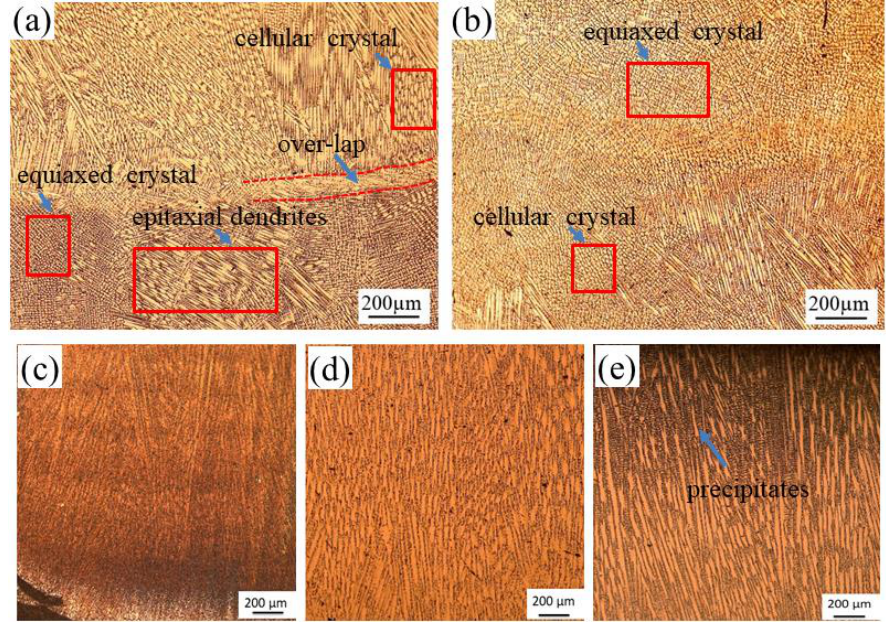
Figure 3. Optical microstructures of the HX1 and HX2 coatings: ( a ) the microstructure of the surface of the HX1 coating; ( b ) the microstructure of the surface of HX2 coating; ( c – e ) the microstructures of the bottom, medium, and top cross-sections of the HX2 coating, respectively.